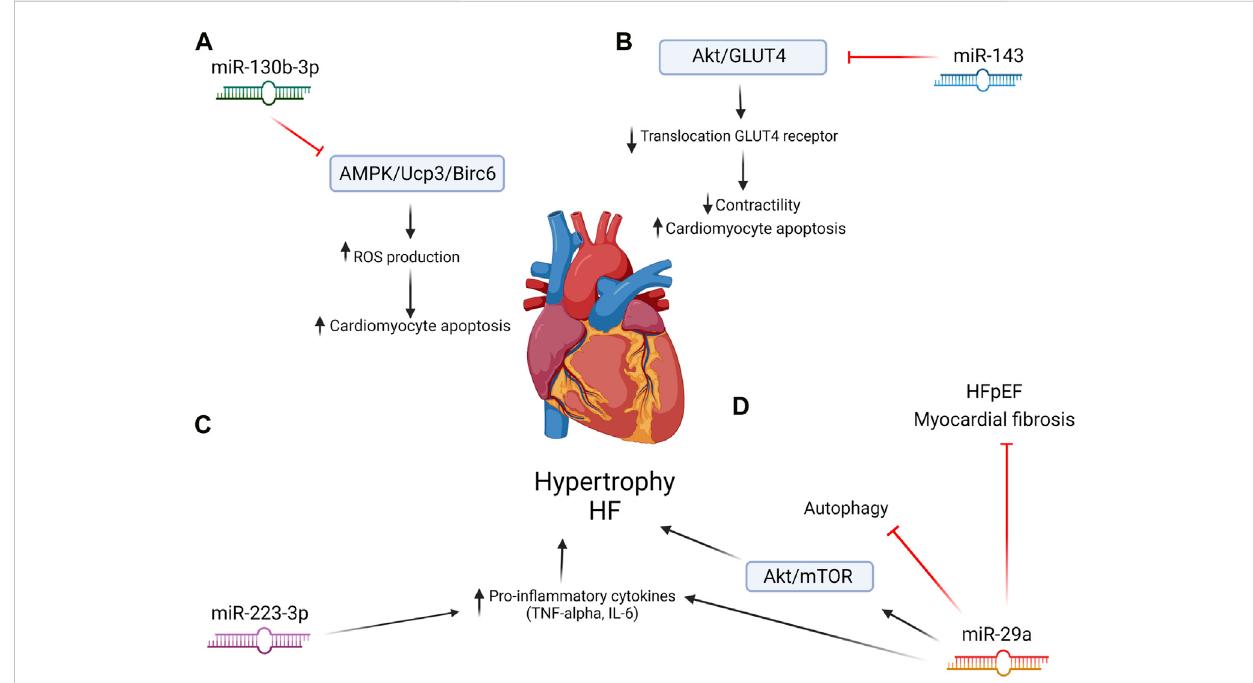
AT-derived microRNAs and their impacts on heart failure and cardiac hypertrophy. (A) miR-130b-3p inhibits the AMPK/Ucp3/Birc6 pathway, which increases ROS production and cardiomyocyte damage. (B) miR-143 inhibits the Akt/GLUT4 pathway, resulting in decreased contractility